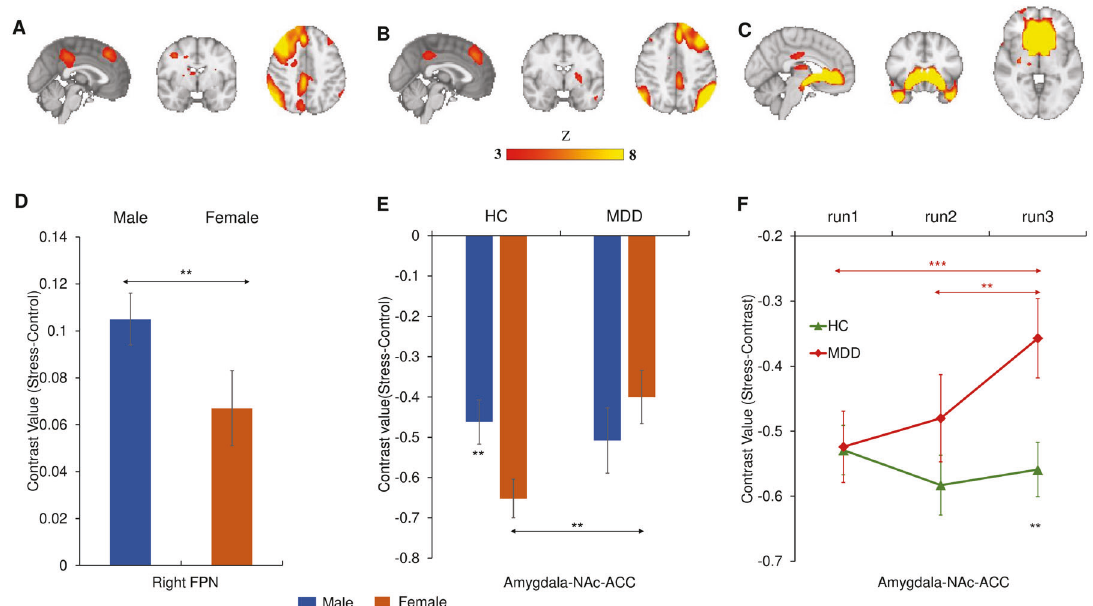
Fig. 4 Neural network responses to acute psychosocial stress. Group spatial maps of the ( A ) right frontoparietal network, ( B ) the left frontoparietal network, and ( C ) amygdala-NAc-ACC network. D Sex differences in the right frontoparietal network. E Sex × Diagnosis interaction effect in the amygdala-NAc-ACC network. F Diagnosis × Time interaction effect in the amygdala-NAc-ACC network. Estimated- mean are plotted, and error bars represent SE. HC healthy controls, MDD major depressive disorder, FPN frontoparietal network, NAc nucleus accumbens, ACC anterior cingulate cortex. * p Bonferroni < 0.05, ** p Bonferroni < 0.01, *** p Bonferroni <